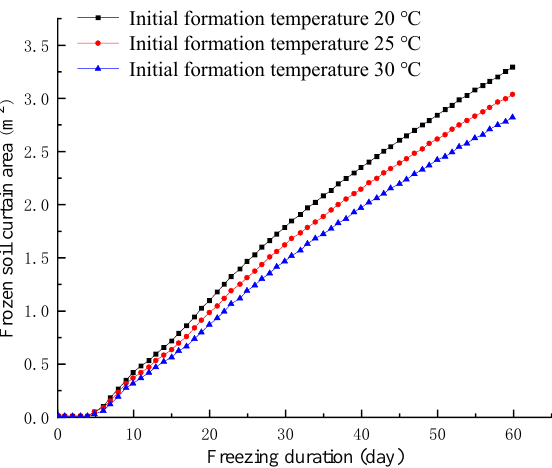
Figure 7. The thickness of frozen soil between steel pipes.